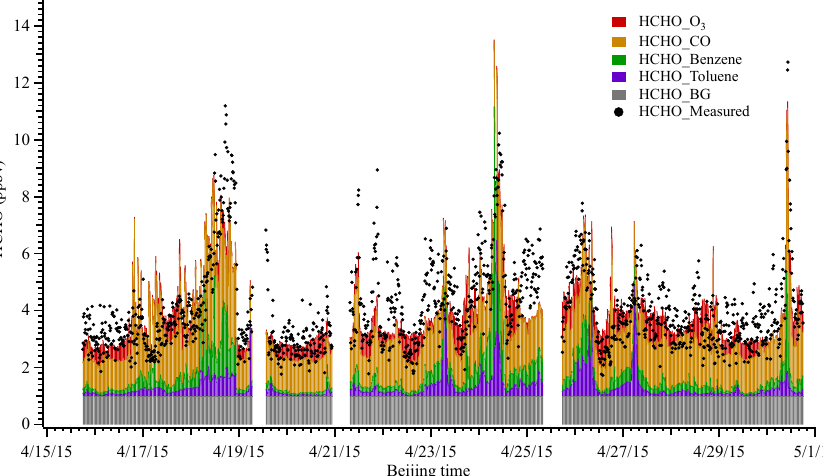
Figure 10. Comparisons of the measured HCHO and source-apportioned HCHO from the multiple linear regression fit. Measured HCHO is denoted by black dots and contributions from different sources are shown as color-coded bars.